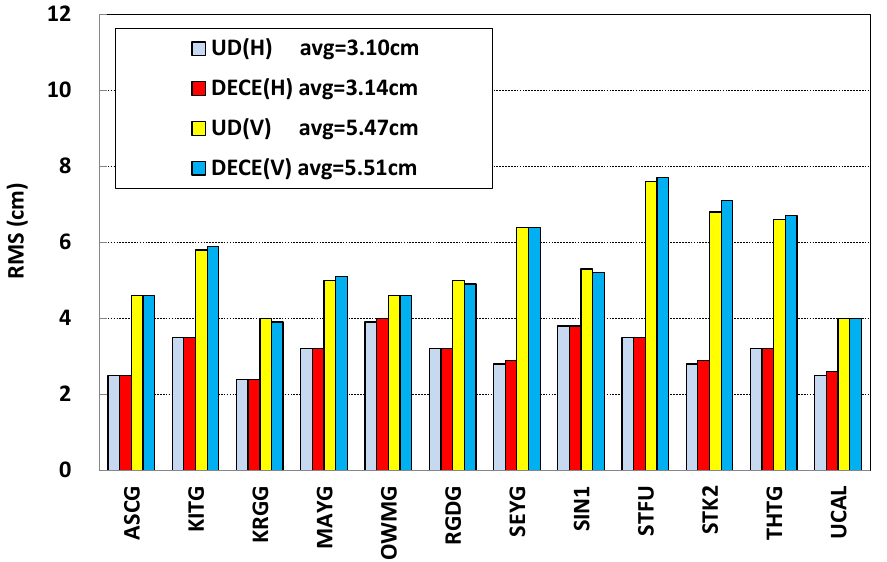
Figure 12. RMS of real-time precise point positioning (PPP) position differenced with respect to their ground truth using decentralized clock estimation (DECE) and undifferenced (UD) products.